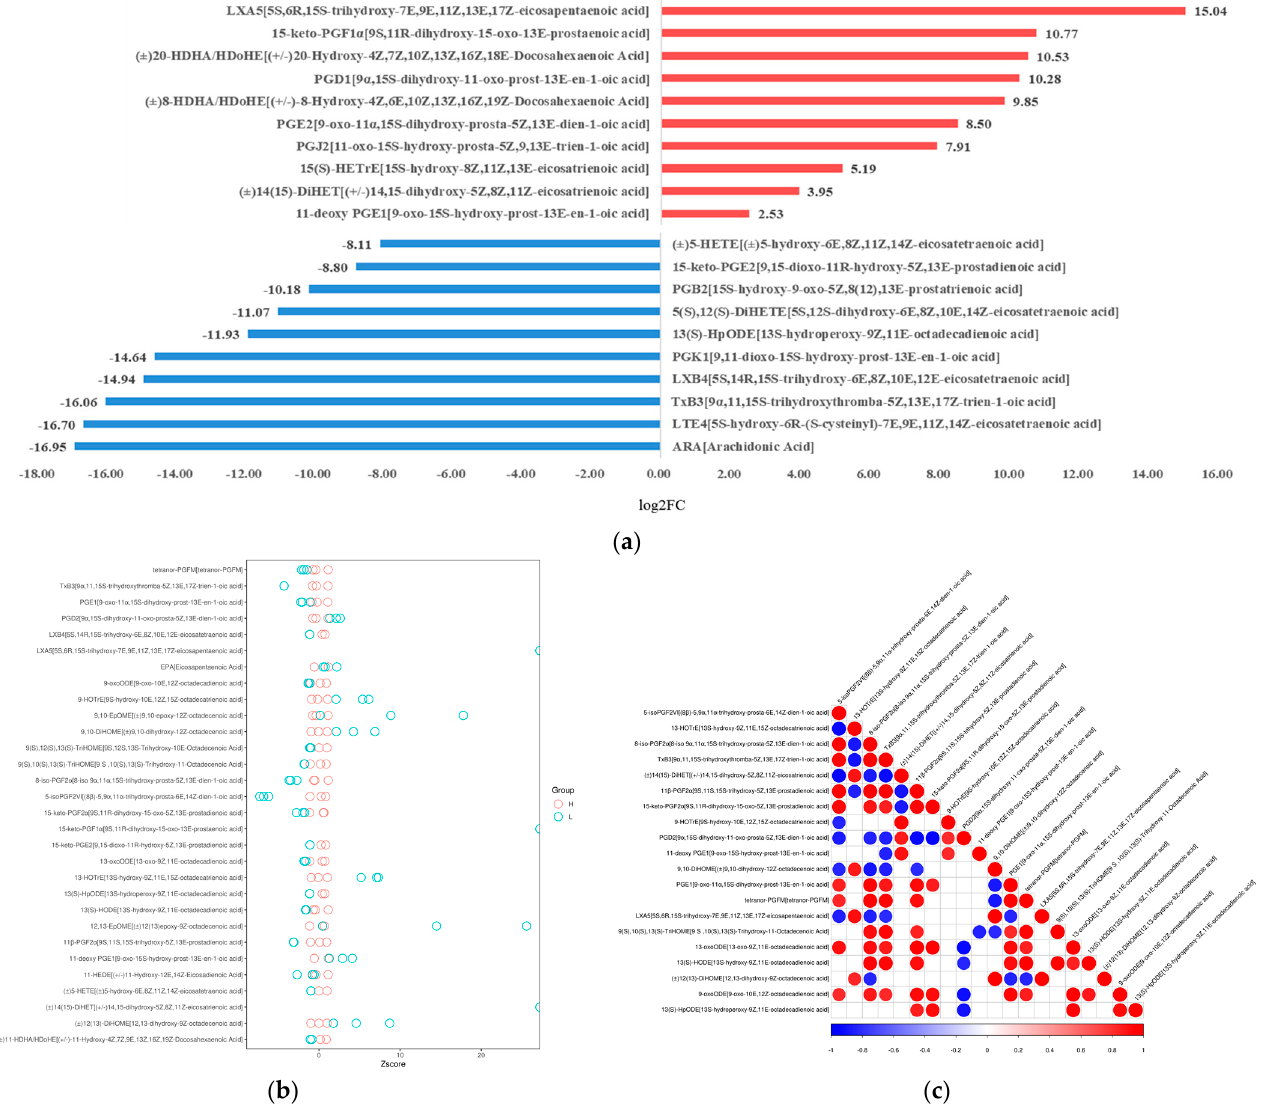
Figure 3. Quantitative analysis of oxidized lipid metabolite levels of A. ochraceus with different population densities. ( a ) A statistical chart of the differential metabolite variance. After log conversion of differential metabolite multiples, the log2FC results of the top 10 metabolites up − regulating and down − regulating in the experimental group compared with the control group are shown in the figure. ( b ) The Z − score was calculated based on the mean and standard deviation of the reference data set (control group), and the top 30 differential metabolites sorted by p − value are shown in the Z-score plot. ( c ) Differential metabolite correlation analysis. The linear relationship between the two metabolites tends to 1 (red) when they are positively correlated and − 1 (blue) when they are negatively correlated.